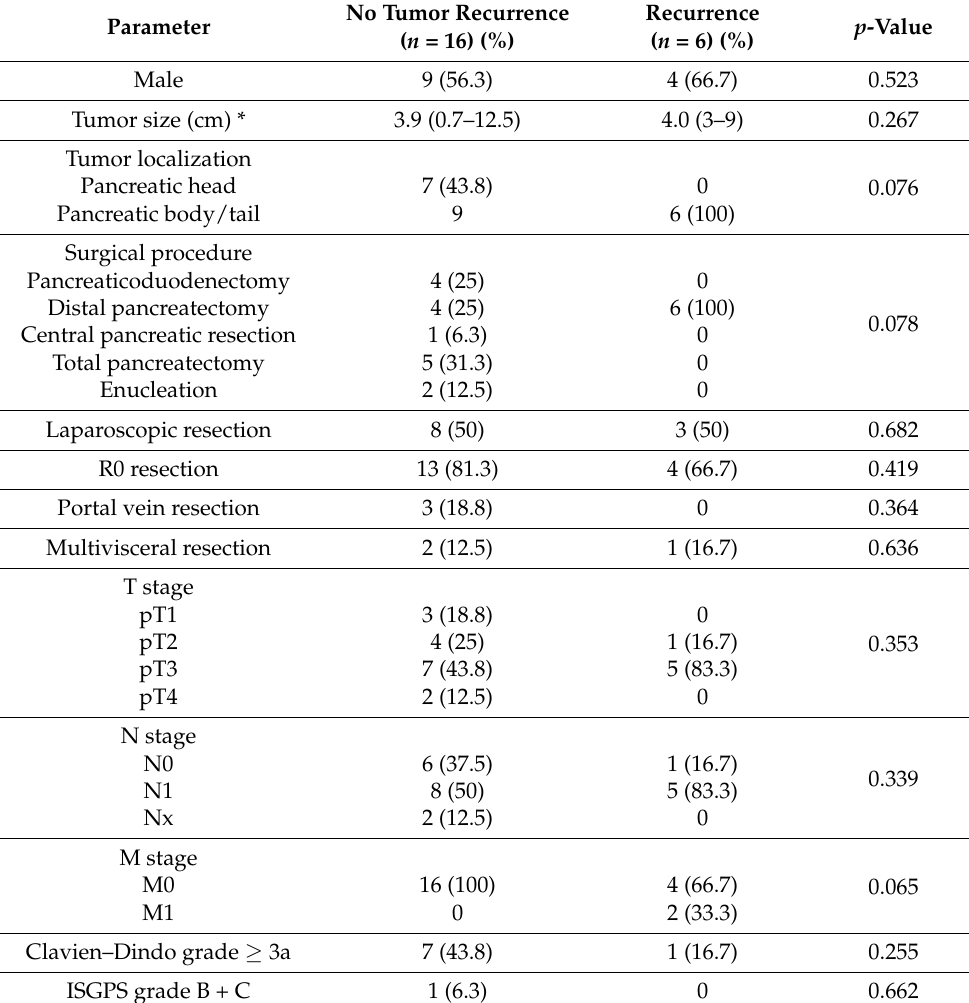
Table 5. Comparison of the patients with and without tumor recurrence in G2 pNEN ( n =